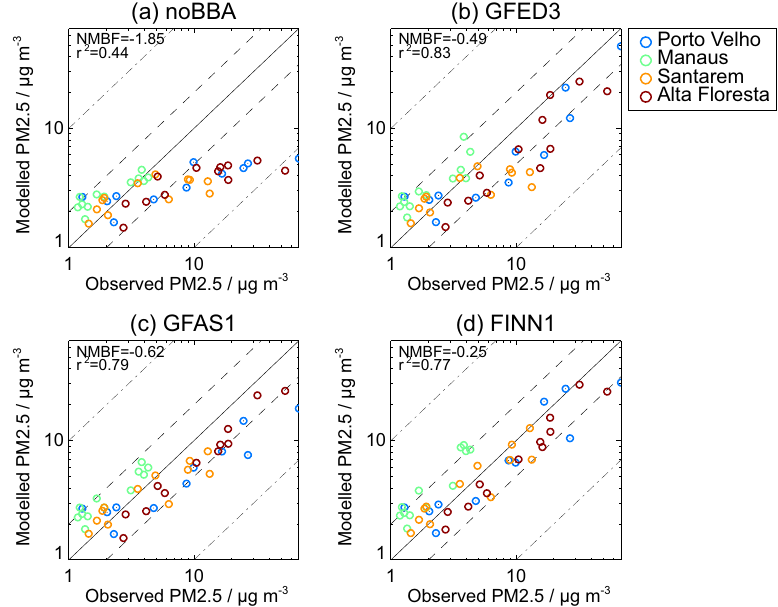
Figure 2. Simulated vs. observed multi-annual monthly mean PM 2 . 5 concentrations at each ground station in the Amazon region for the model (a) without biomass burning emissions, and with (b) GFED3, (c) GFAS1 and (d) FINN1 emissions. Multi-annual monthly mean concentrations were calculated by averaging over all years of data available between January 2003 and December 2011 to obtain an average seasonal cycle at each station. The normalised mean bias factor (NMBF; Yu et al., 2006) and Pearson’s correlation ( r 2 ) between modelled and observed PM 2 . 5 concentrations are shown in the top left corner.